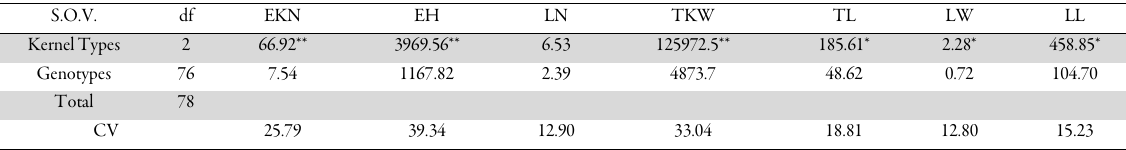
Table 2. Mean squares of analysis for some agronomic-morphological traits among 79 local maize genotypes S.O.V. df EKN EH LN TKW TL LW LL Kernel Types